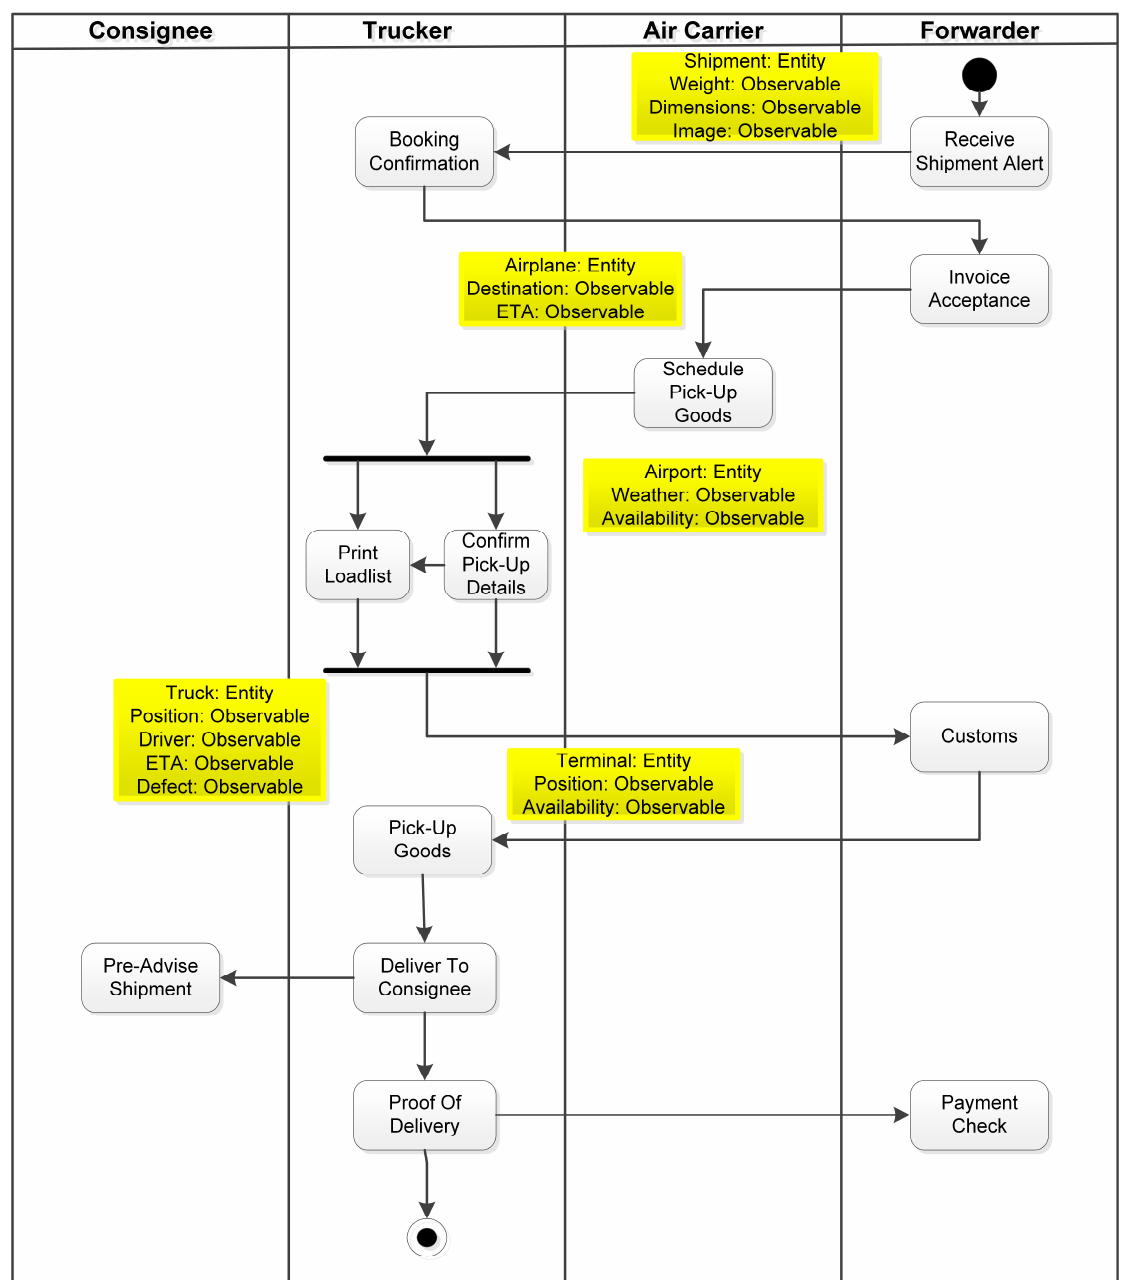
Figure 6. Activity diagram of the transportation use case example with exception-related events.